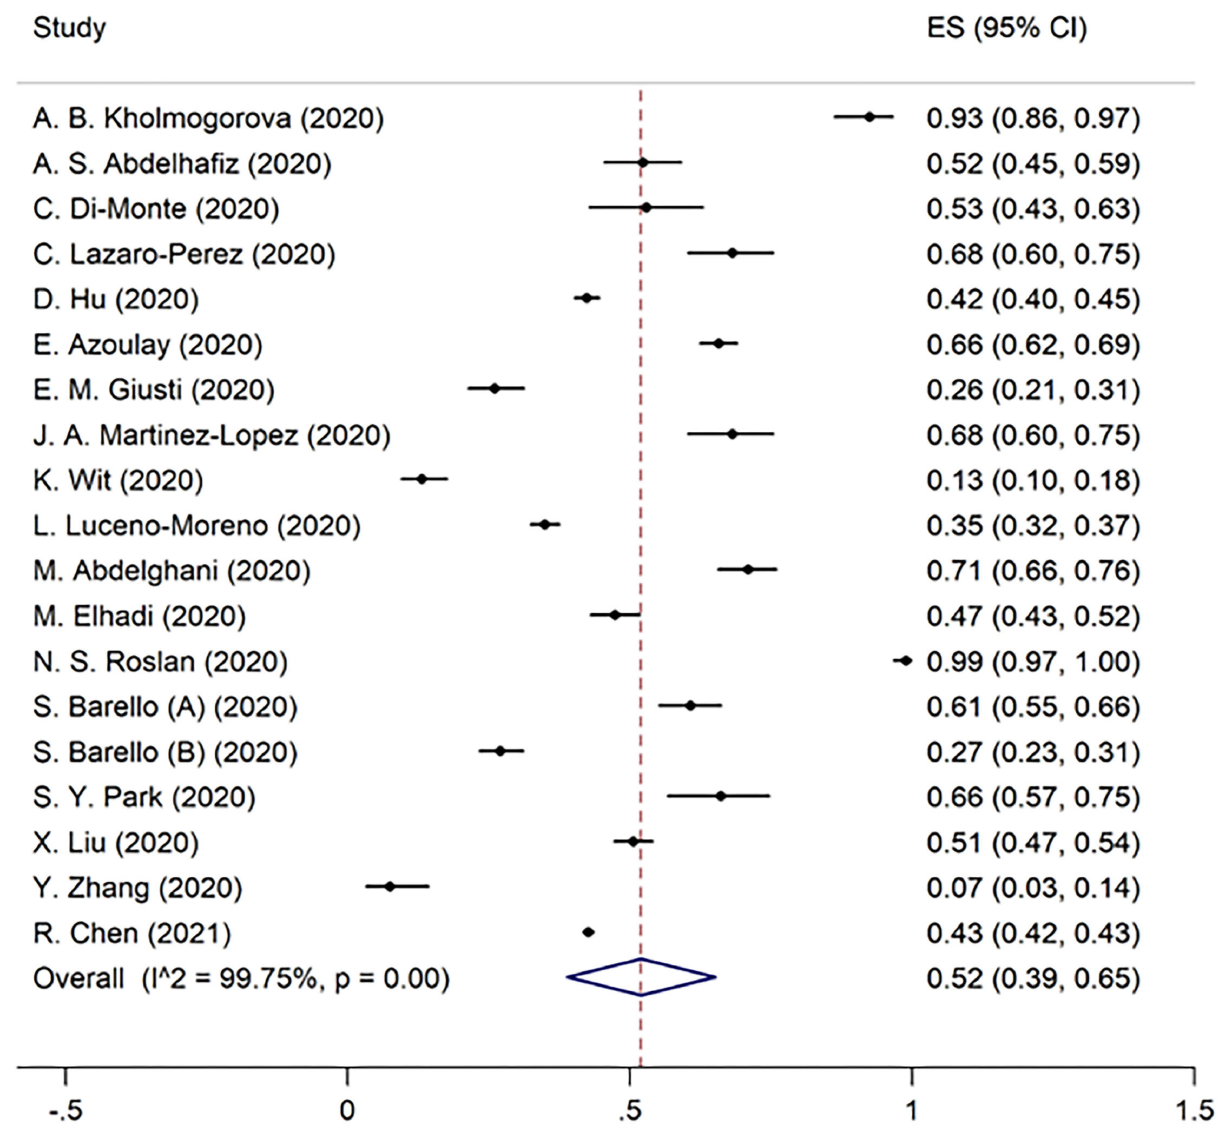
FIGURE 2 | The pooled prevalence of overall burnout in included